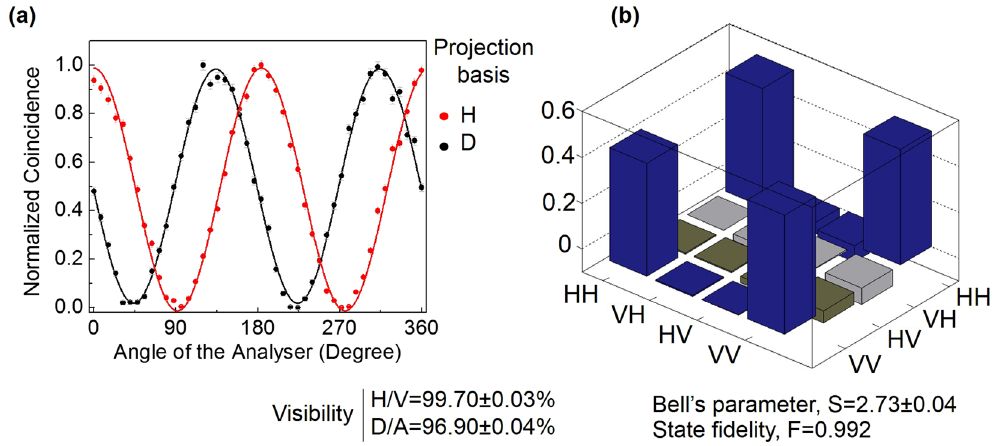
Figure 2. Study on two-photon polarization entanglement, and identification of the state. ( a ) Visibility graph of polarization entangled state at H (red dots) and D (black dots) bases. ( b ) Graphical representation of the density matrix obtained from linear tomographic technique for polarization entangled